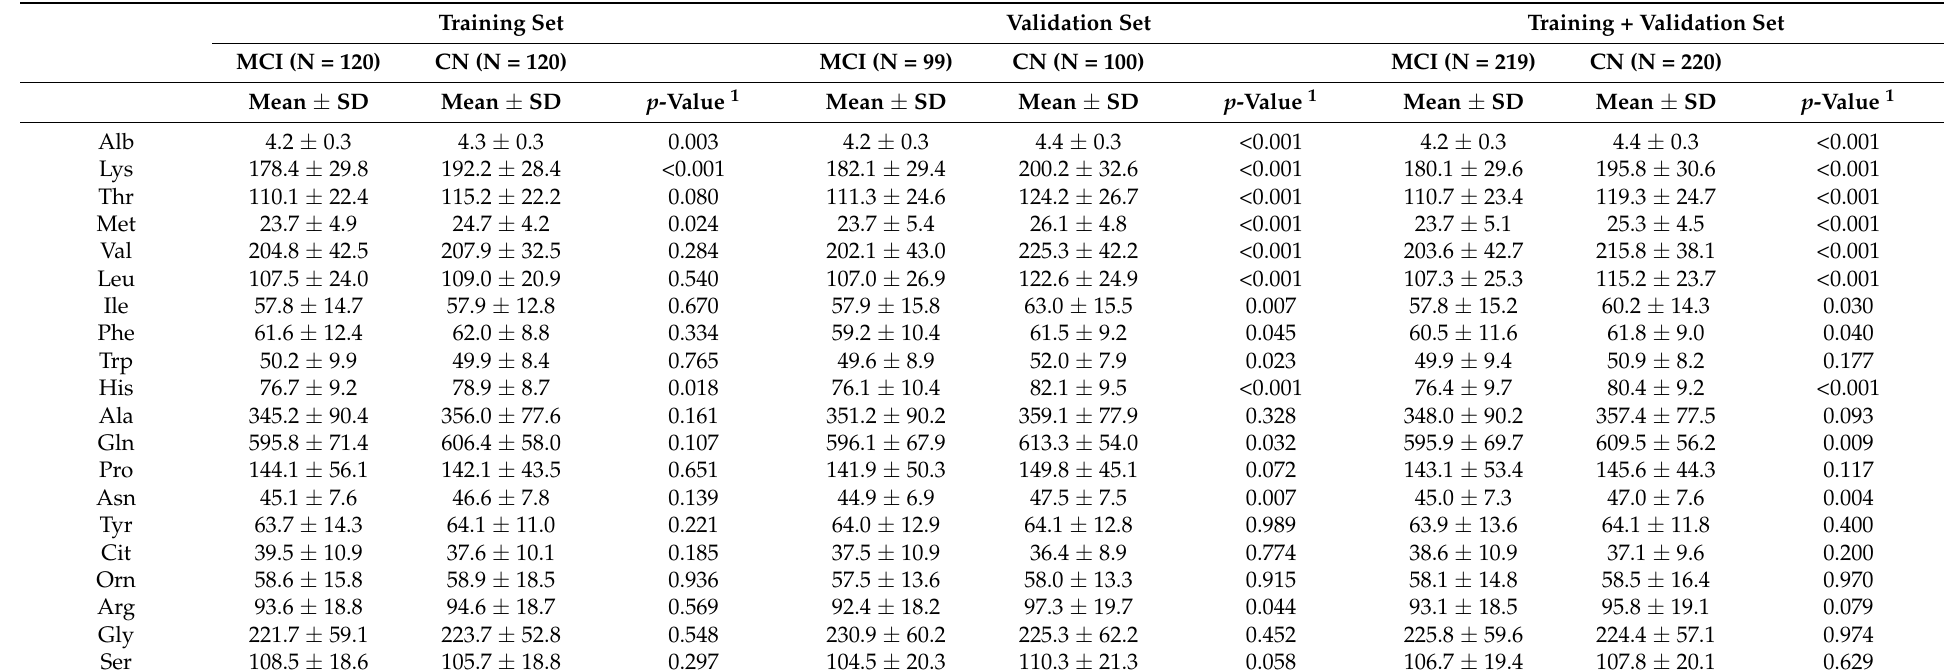
Table 2. Albumin (g/dL) and PFAA concentrations ( µ mol/L) in the MCI and CN